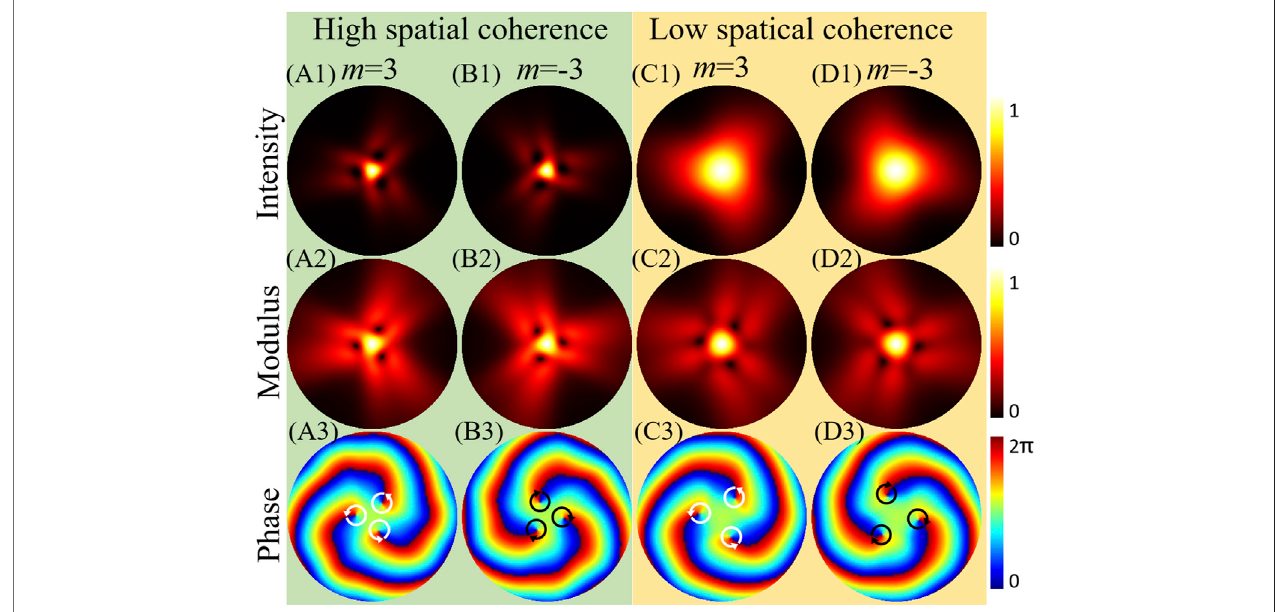
FIGURE7| Numerical simulation intensitiesandCSDdistributions ofthePC-PEPVbeamsonthefocalplanewithpositiveand negativeTCsandpowerorder n (cid:1) 3 underhighandlowspatialcoherence( σ (cid:1) 20and0.5 mm). (A1 – D1) aretheintensitypatterns, (A2 – D2) arethemodulusoftheCSDfunction,and (A3 – D3) arethephase patterns of the CSD function. White circular arrows represent the anticlockwise direction of the phase winding which indicates the positive TC.